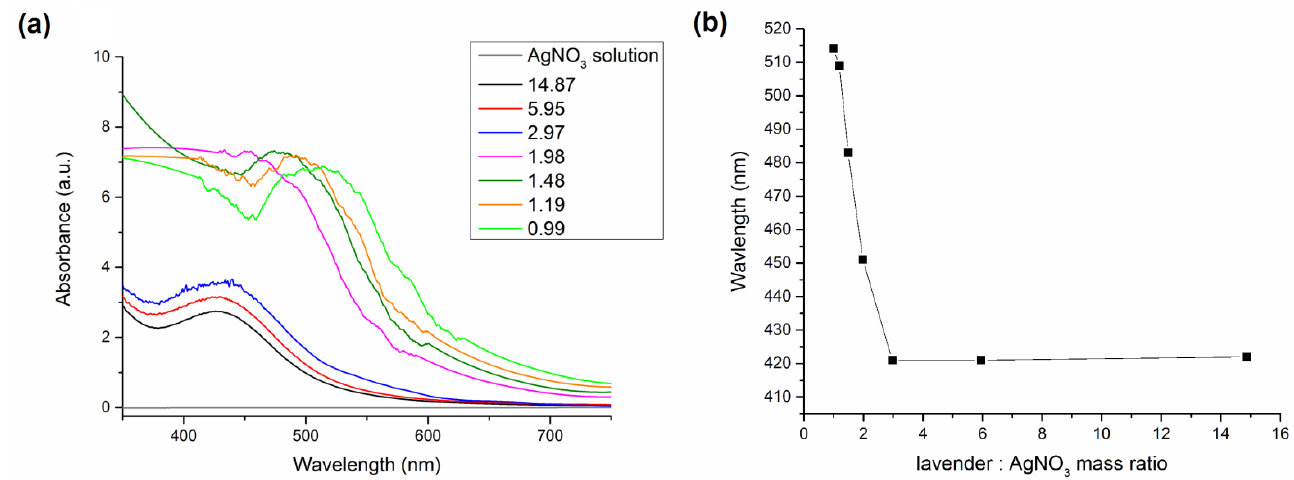
Figure 1. ( a ) Ultraviolet-visible (UV-Vis) spectra of the final products of green synthesis at various lavender:AgNO 3 ratios; ( b ) dependence on the wavelength of absorbance maximum on the lavender:AgNO 3 ratios.